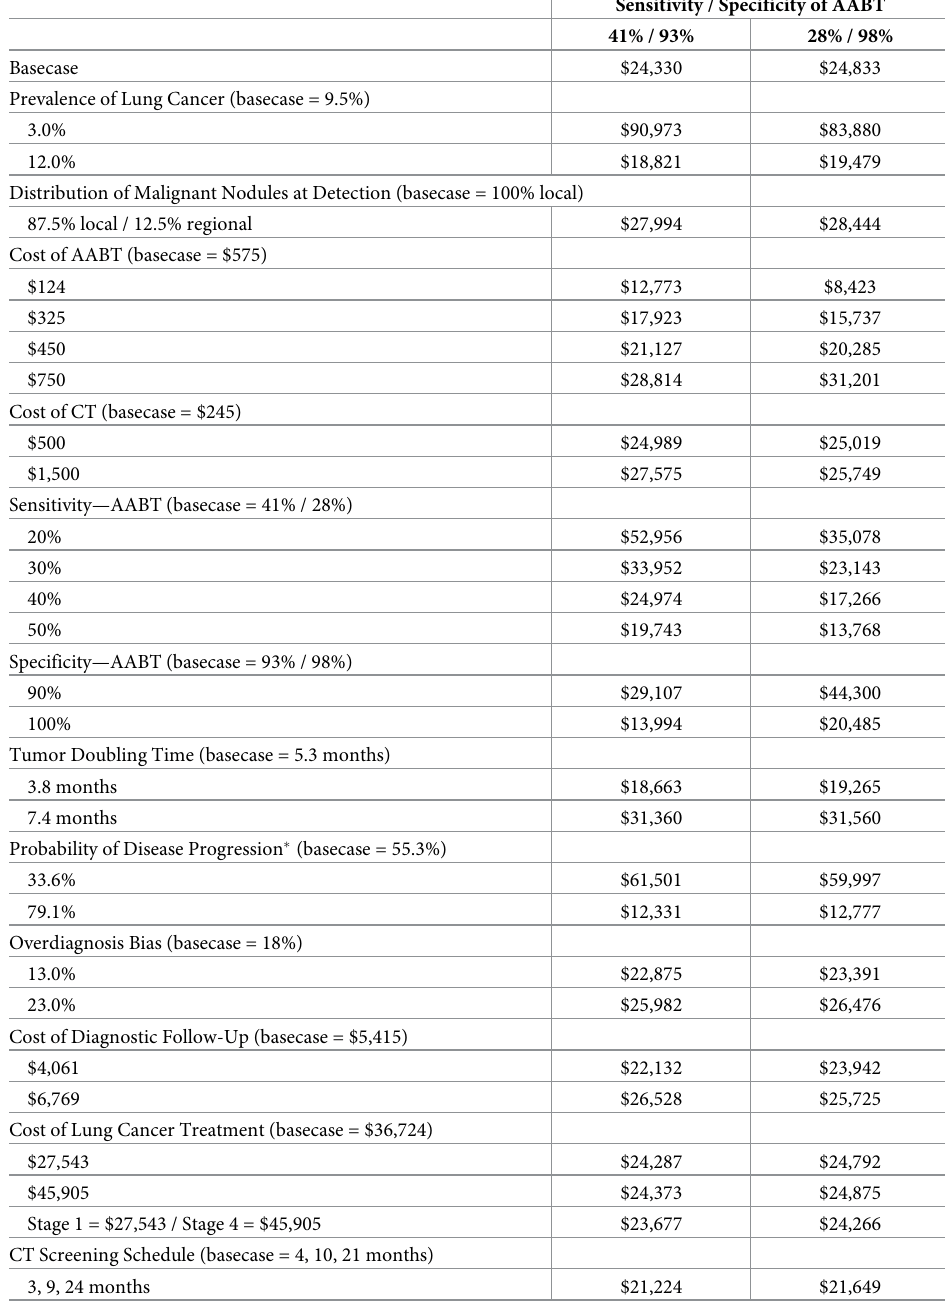
Table 4. Sensitivity analyses on cost-effectiveness (cost per QALY gained) of using AABT versus CT surveillance alone for early diagnosis of lung cancer in patients who have incidentally detected pulmonary nodules, are at intermediate risk, and were scheduled for CT surveillance